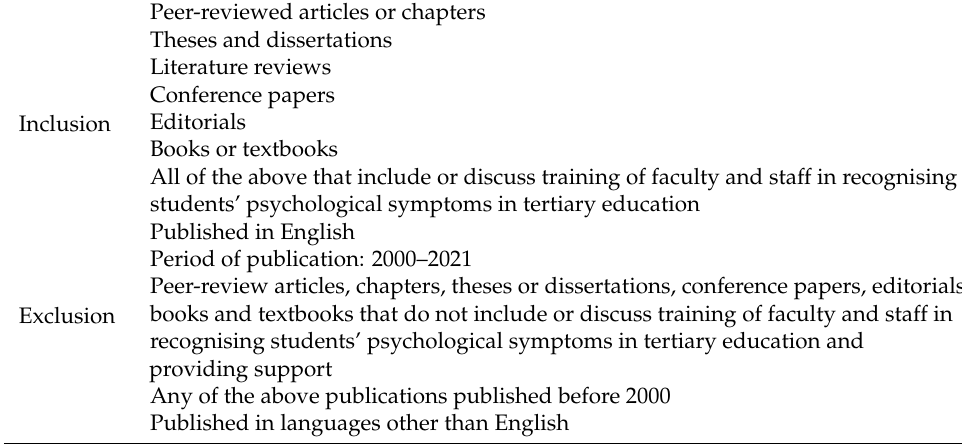
Table 1. Inclusion and exclusion